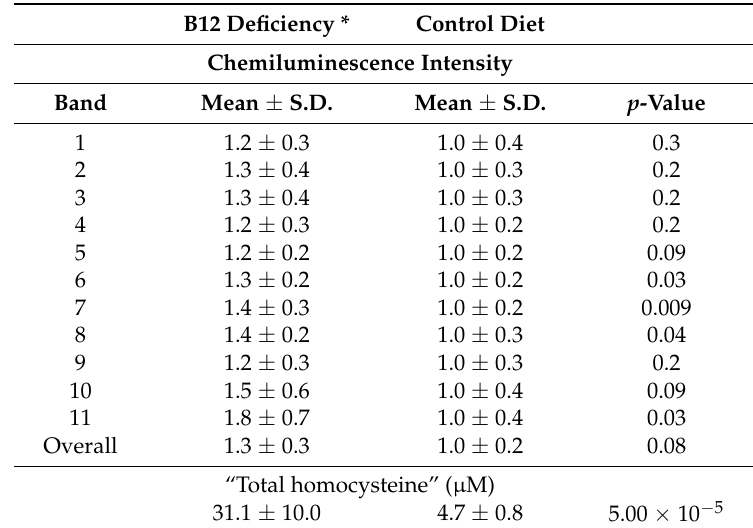
Table 1. Chemiluminescence intensities of biotin-labeled proteins ( N -homocysteinylation) and “total homocysteine” concentration of rat